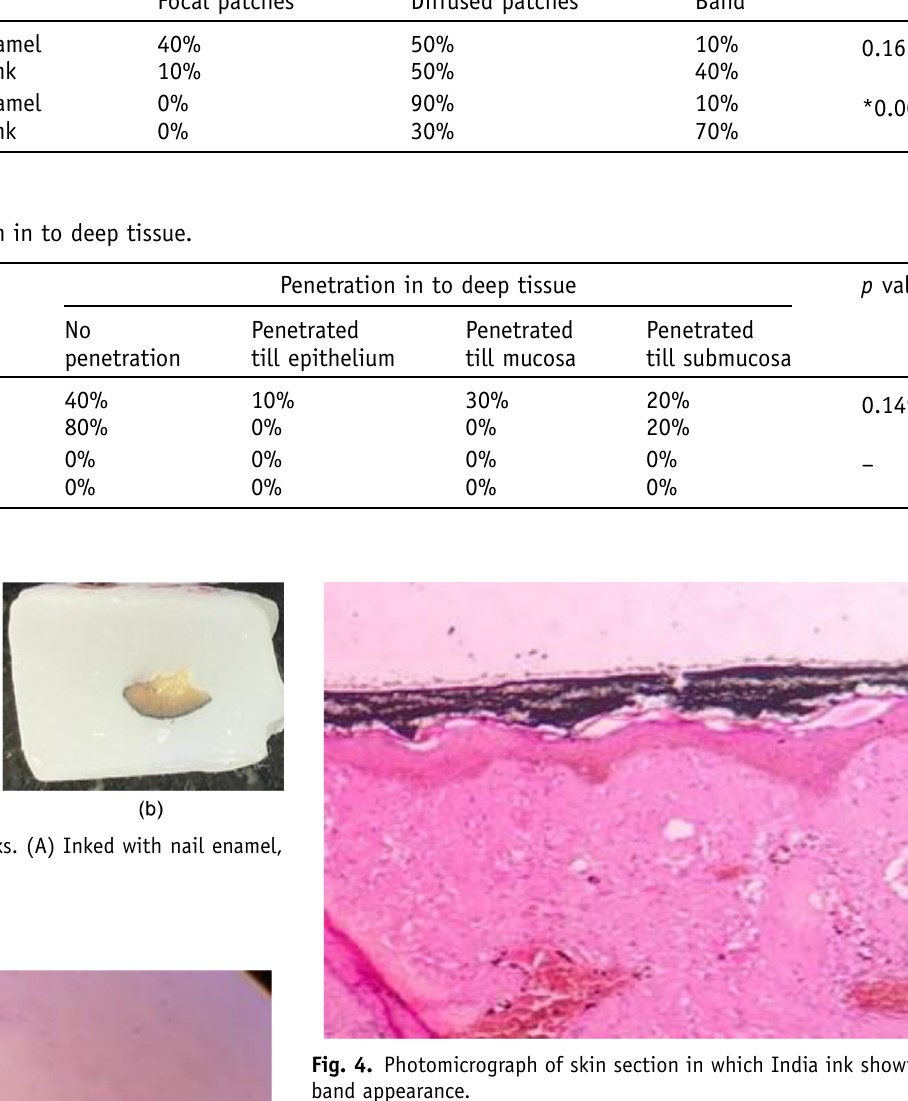
Table III. Ink used vs visibility on microscope. Specimen type